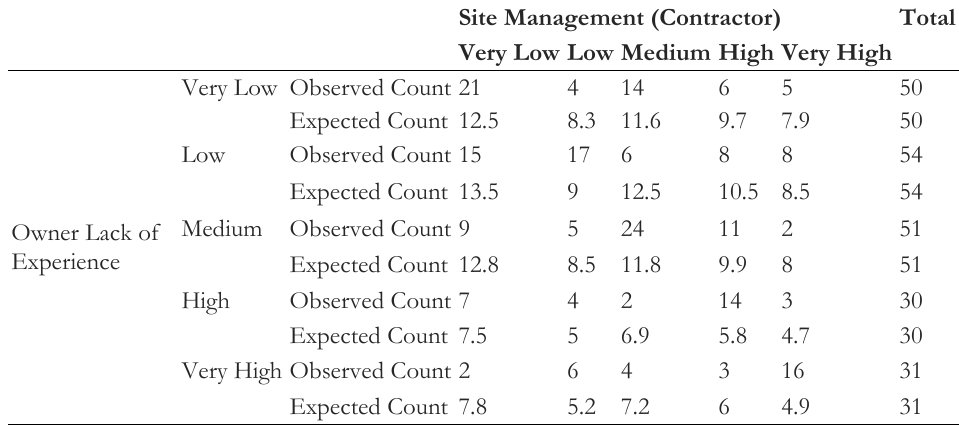
Table 7. Owner lack of experience * site management of contractor cross